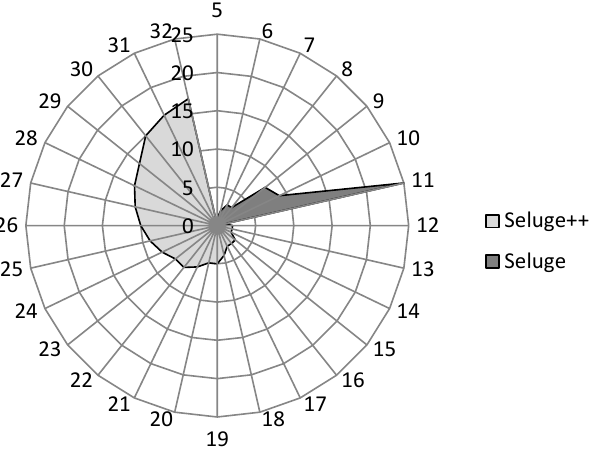
Range support of Seluge and Seluge++ for a range of sequential hash block